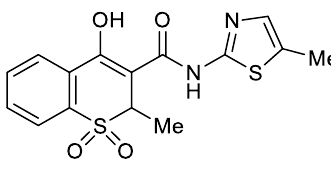
Figure 1. Structure of meloxicam.